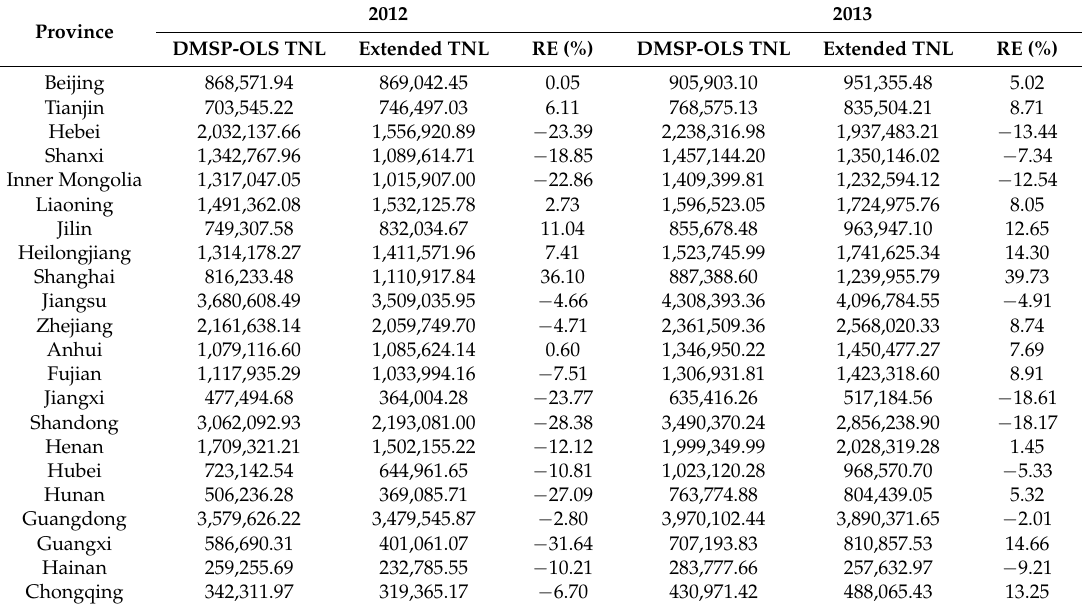
Table 2. Accuracy assessment of the TNL generated using NPP-VIIRS data and the TNL generated using DMSP-OLS data in 2012 and 2013.